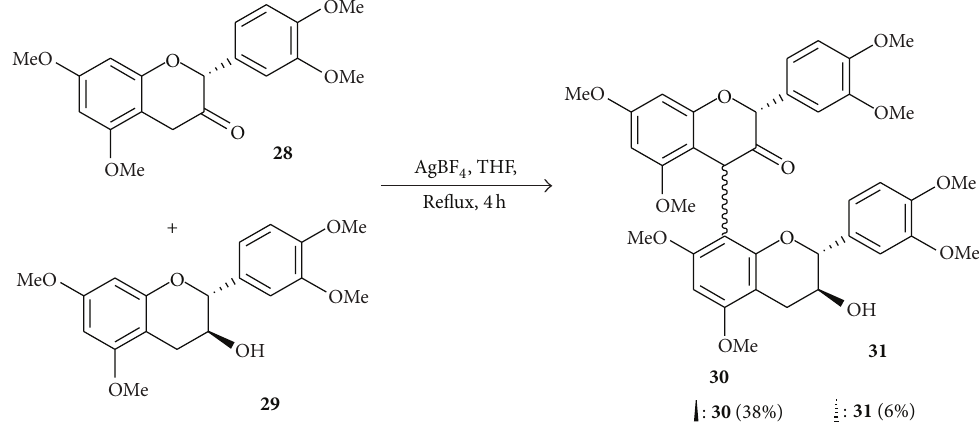
Scheme 4: Condensation reaction between 28 and 29